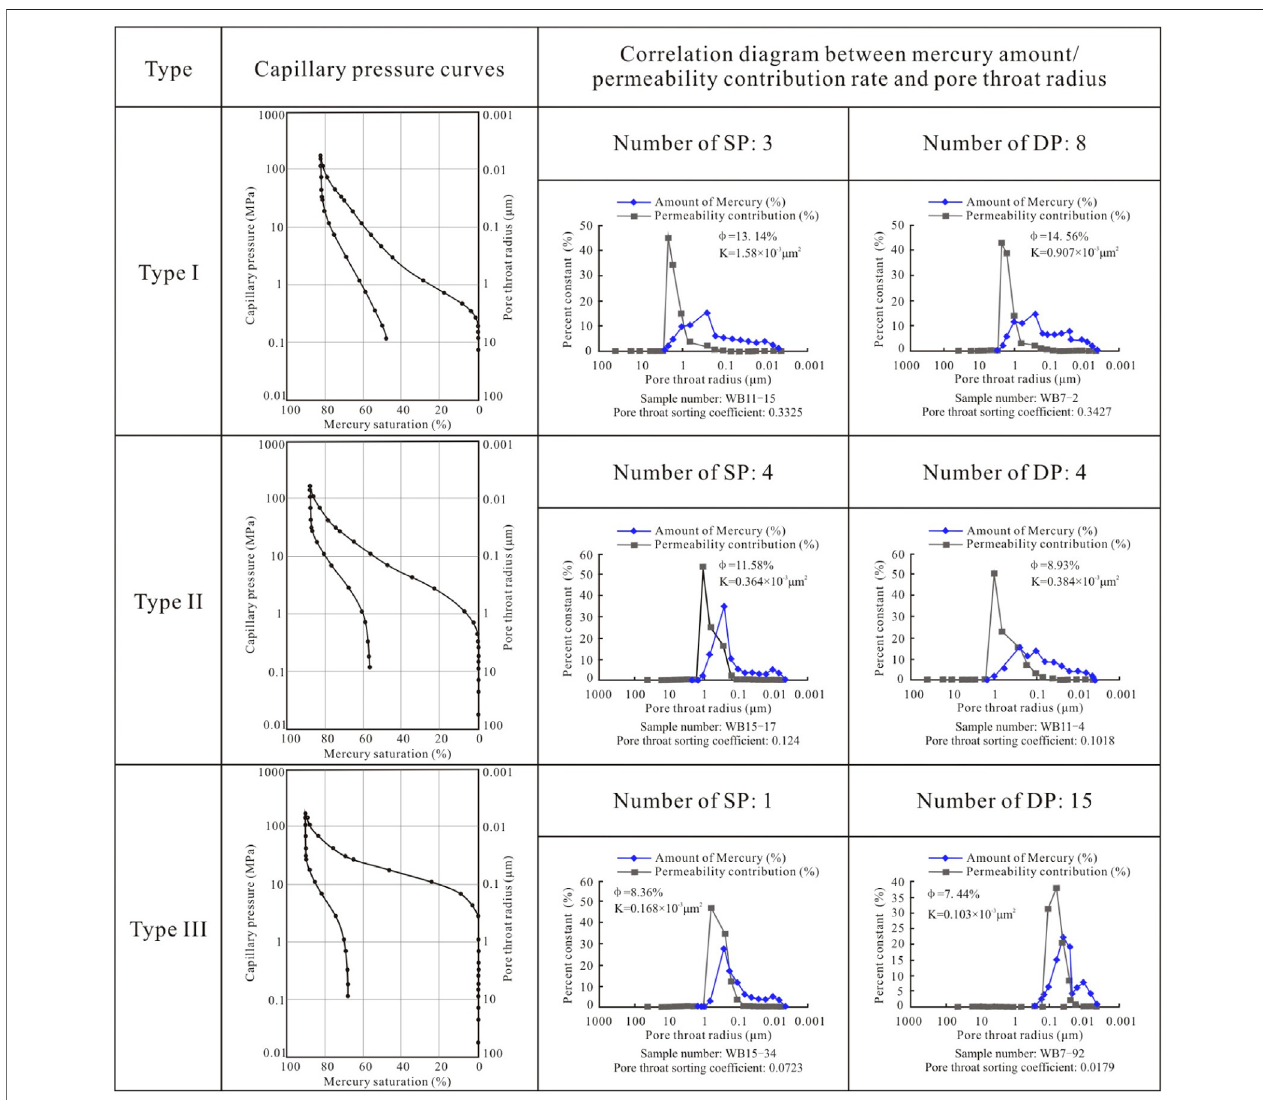
FIGURE 8 | Comparison of capillary pressure curves and mercury intrusion parameters of different types of samples in the Chang 3 Member. Notes: SP, single peak; DP, double peak.